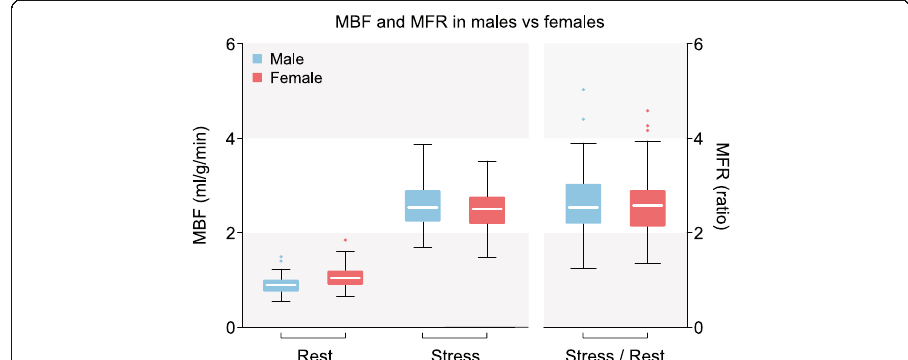
Fig. 1 MBF and MFR by sex. Boxplot with Tukey whiskers, dots are outliers. MBF = Myocardial Blood Flow, MFR = Myocardial Flow